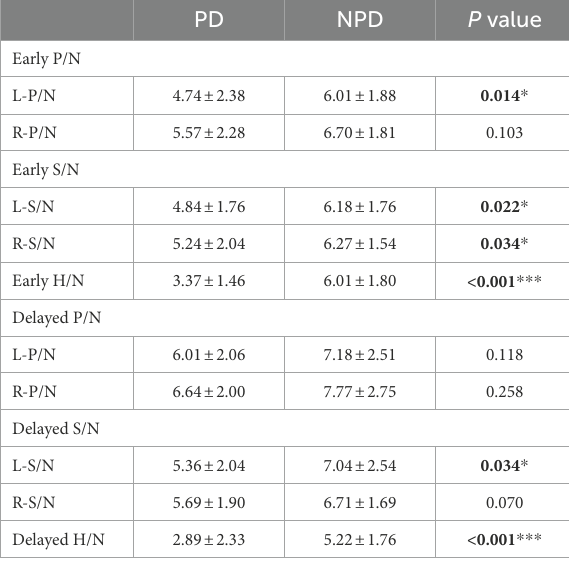
TABLE 1 Differences of salivary gland and myocardial MIBG scintigraphy results in PD and NPD. PD NPD P value